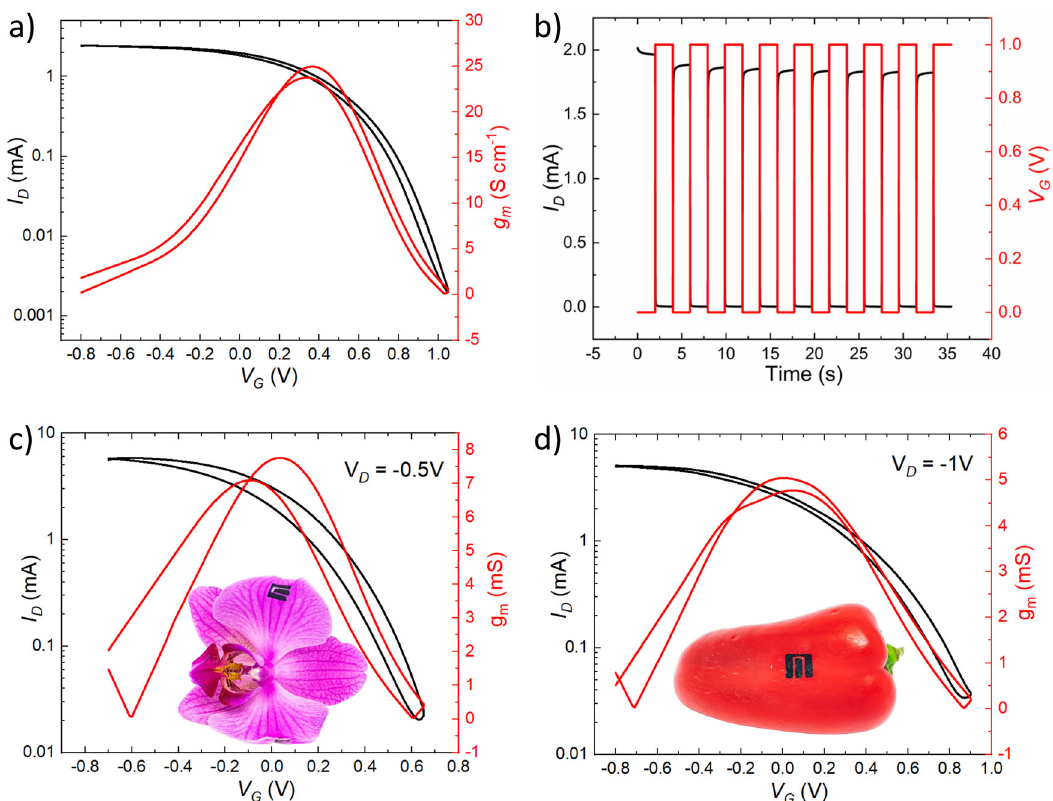
Fig. 4 OECTs printed on unconventional substrates. a Transfer curve and normalized transconductance of OECTs printed on c-NFC. b I D response to V G pulsing from 0 to 1 V. Transfer curves of OECTs directly printed on ( c ) an orchid fl ower and ( d ) a bell